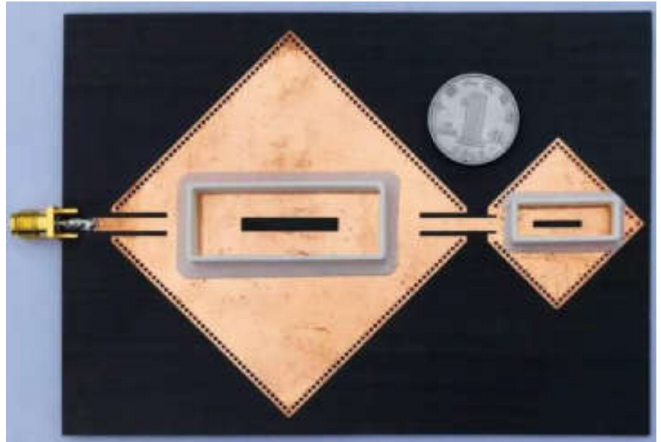
Figure 4. The fabricated SIW resonator sensor.